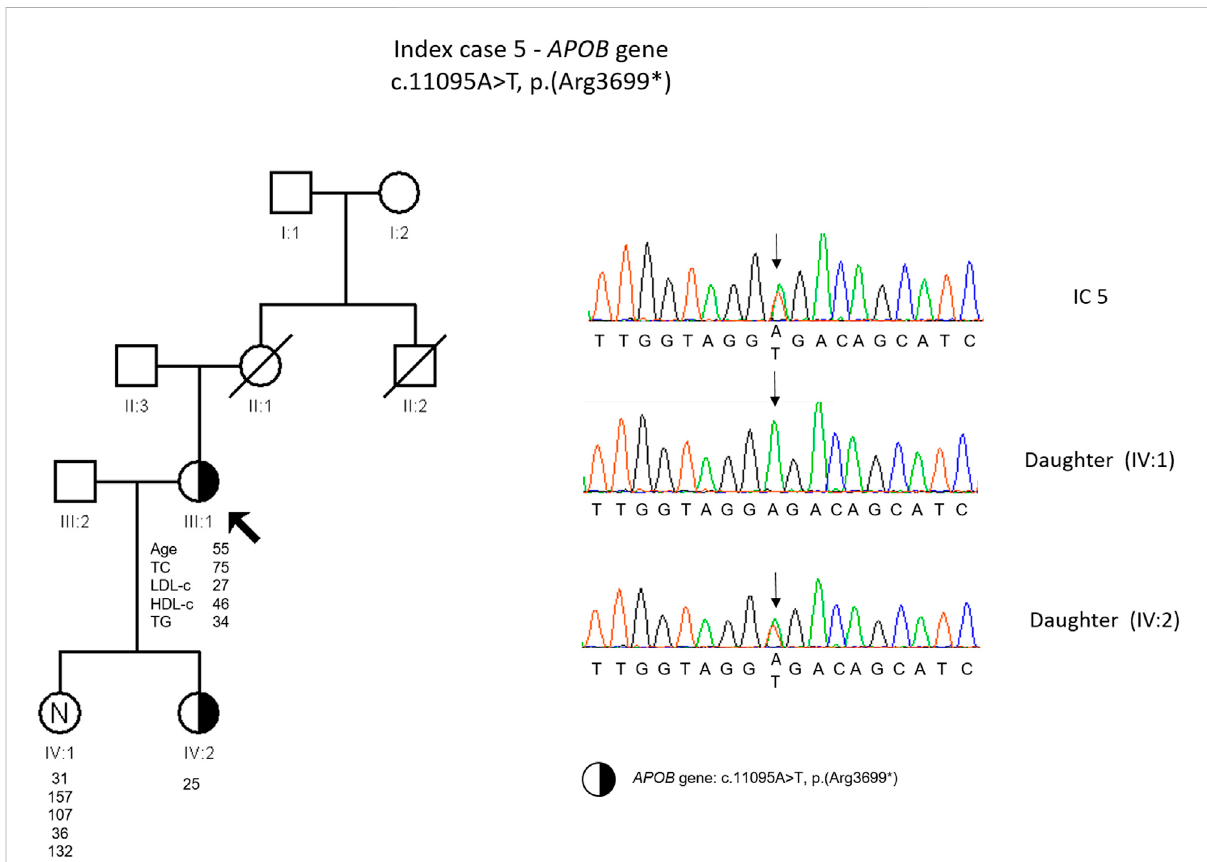
FIGURE 5 Arrow indicates index case 5 (IC5). Age (in years) and lipid pro fi le in mg/dL are under each symbol. Half- fi lled symbol represent heterozygous individual for the variant in APOB gene, c.11095A > T, p.(Arg3699*); Partial sequence APOB gene of IC5 and family